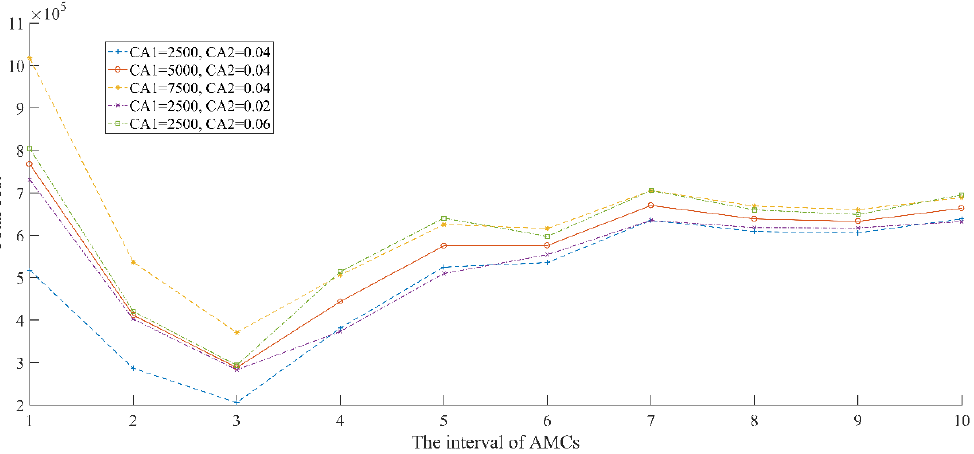
Figure 9. Expected total cost C vs. A for, M 0 = 10 4 , r = 0.5, α = 1, β = 0.01, C P = 7, as well as for different values of C A 1 and C A 2